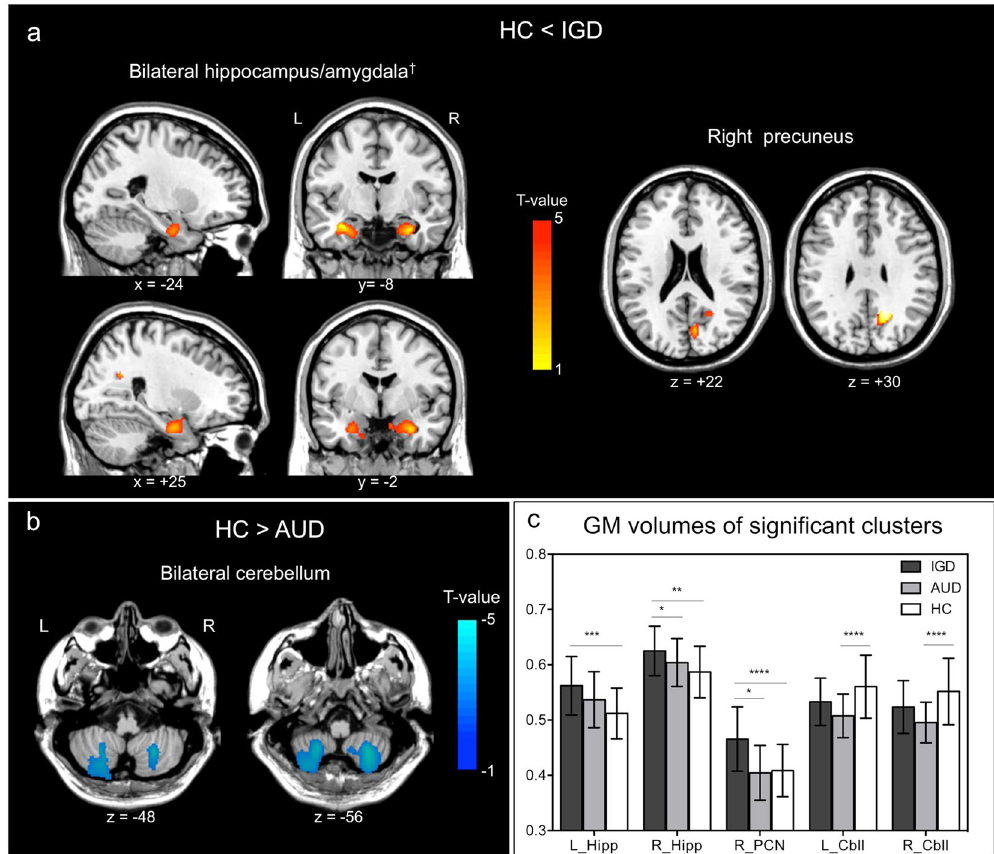
Figure 1. Results of cortical volume comparisons among Internet gaming disorder (IGD), alcohol use disorder (AUD), and healthy controls (HCs). ( a ) Areas of significant larger gray matter volume in IGD than HCs. † The cluster size of the right hippocampus/amygdala did not reach the level of significace (883 voxels; minimum cluster size for significance = 953 voxels). ( b ) Areas of significant smaller gray matter volume in AUD than HCs. ( c ) Average gray matter volumes of the significant clusters for each group. Error bars denote standard error of the mean. * p < 0.05; ** p < 0.01; *** p < 0.005; **** p ≤ 0.001; HC, healthy control; AUD, alcohol use disorder; IGD, Internet gaming disorder; L, left; R, right; L_Hipp, left hippocampus; R_Hipp, right hippocampus; R_ PCN, right precuneus; L_Cbll, left cerebellum; R_Cbll, right cerebellum.